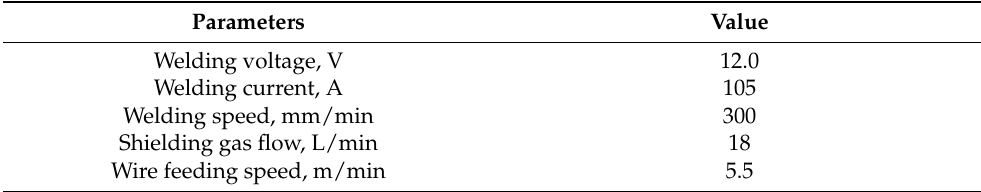
Figure 2. Schematic diagram of CMT welding-brazing process. Table 2. Process parameters of CMT welding brazing